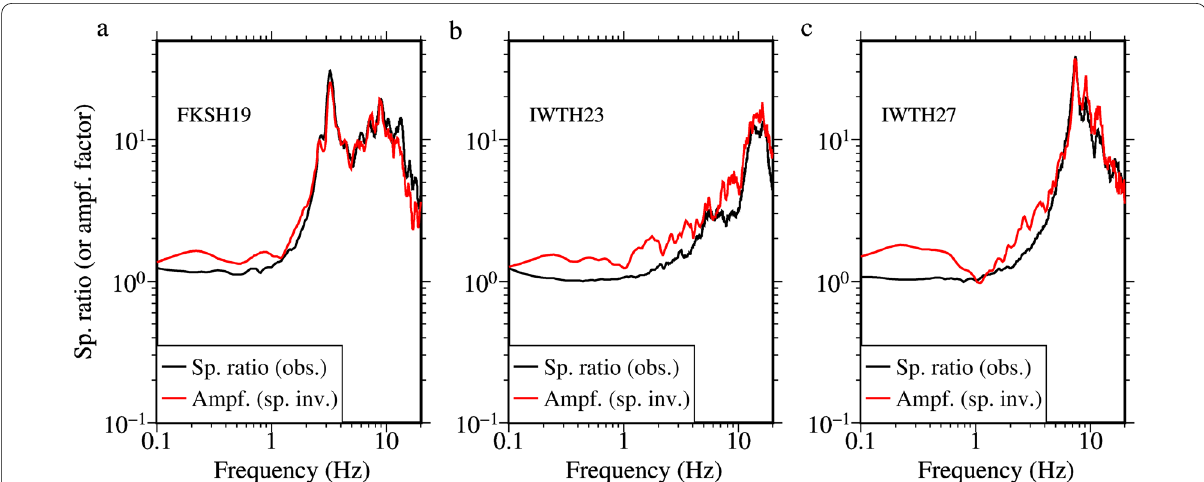
Fig. 8 Comparison of the mean surface-to-borehole spectral ratios of horizontal component recordings (black lines) and site amplification factors (red lines) from the spectral inversion at three KiK-net sites. a FKSH19, b IWTH23, and c IWTH27. See Fig. 1 for the location of the